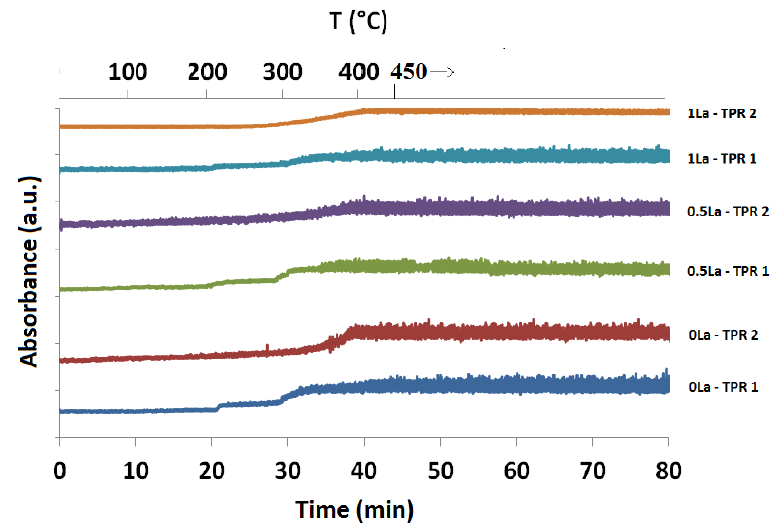
Figure 6. UV-vis absorbance vs. time for the 0La, 0.5La and 1La catalysts during TPR 1 and TPR 2. The absorbance signal increases simultaneously with the increase of the hydrogen consumption signal from the mass spectrometer.